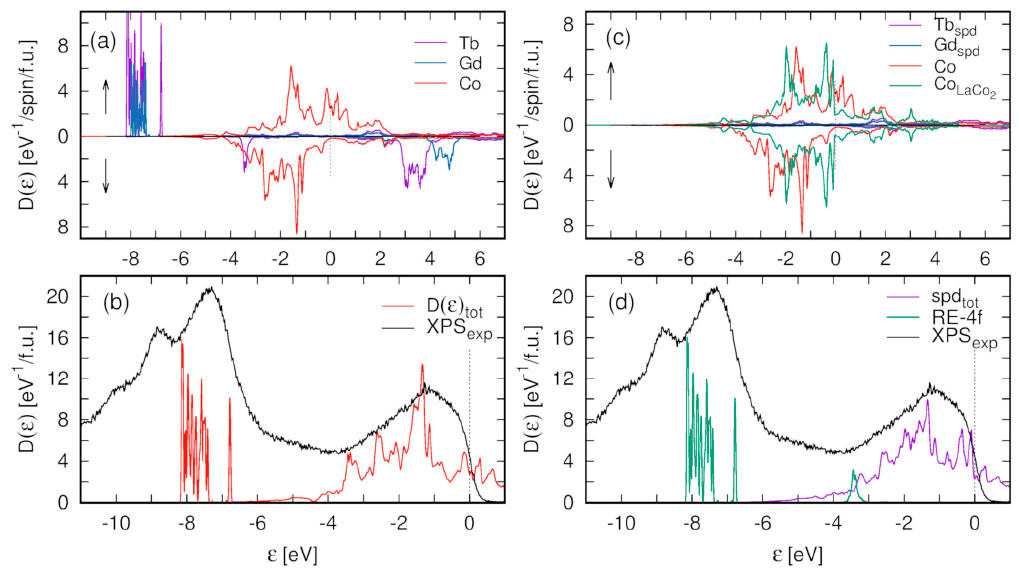
Figure 10. The density of states (DOS) of the Gd 0.375 Tb 0.625 Co 2 calculated within the PBEsol + SO + U method. ( a )—spin-resolved, partial atomic contributions, ( b )—total DOS compared with the scaled XPS spectrum, ( c )—spin-resolved, partial atomic spd DOS in Gd 0.375 Tb 0.625 Co 2 compared with the spd DOS of paramagnetic LaCo 2 compound; ( d )—Gd + Tb 4f DOS combined with the simulated mixture of spd DOS (60%—Gd 0.375 Tb 0.625 Co 2 + 40%—LaCo 2 ) compared with the scaled XPS spectrum.